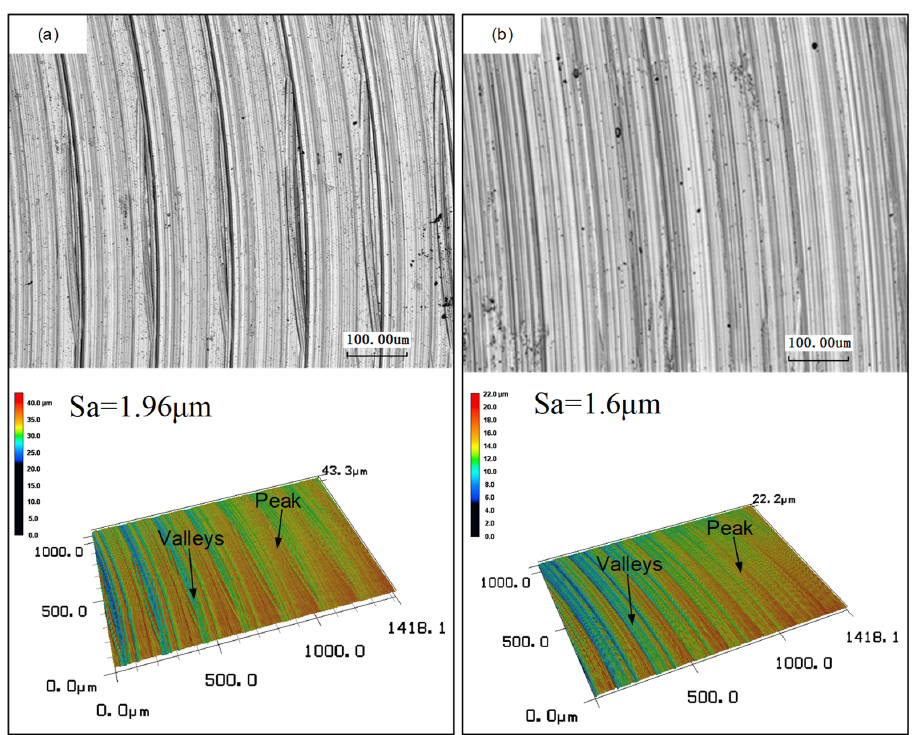
Figure 8. 2D and 3D surface morphology under two cutting fluid conditions: ( a ) CCF-10 ( b ) QC-2803.